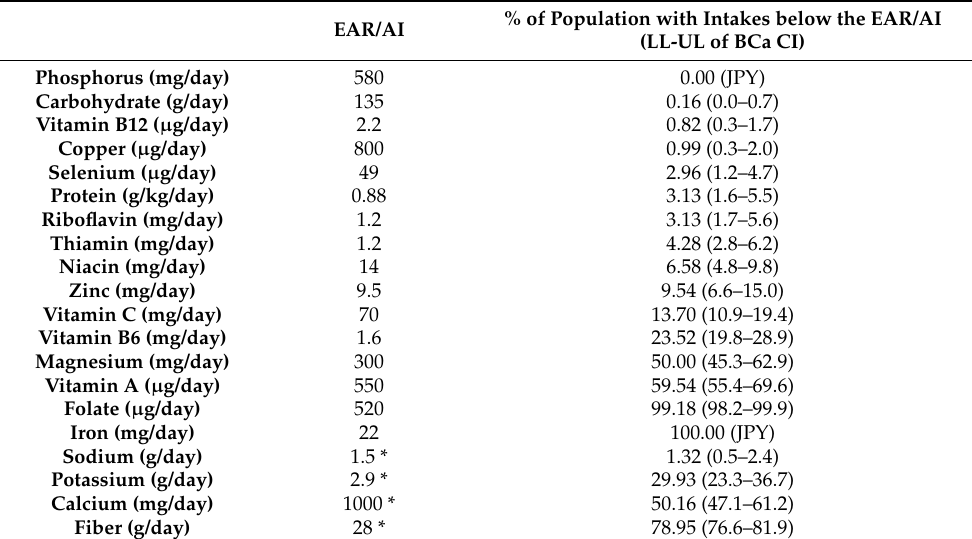
Table 6. Prevalence of inadequacy expressed as point estimates and BCa confidence intervals on the usual intake of study population ( n = 608). % of Population with Intakes below the EAR/AI EAR/AI (LL-UL of BCa CI) Phosphorus